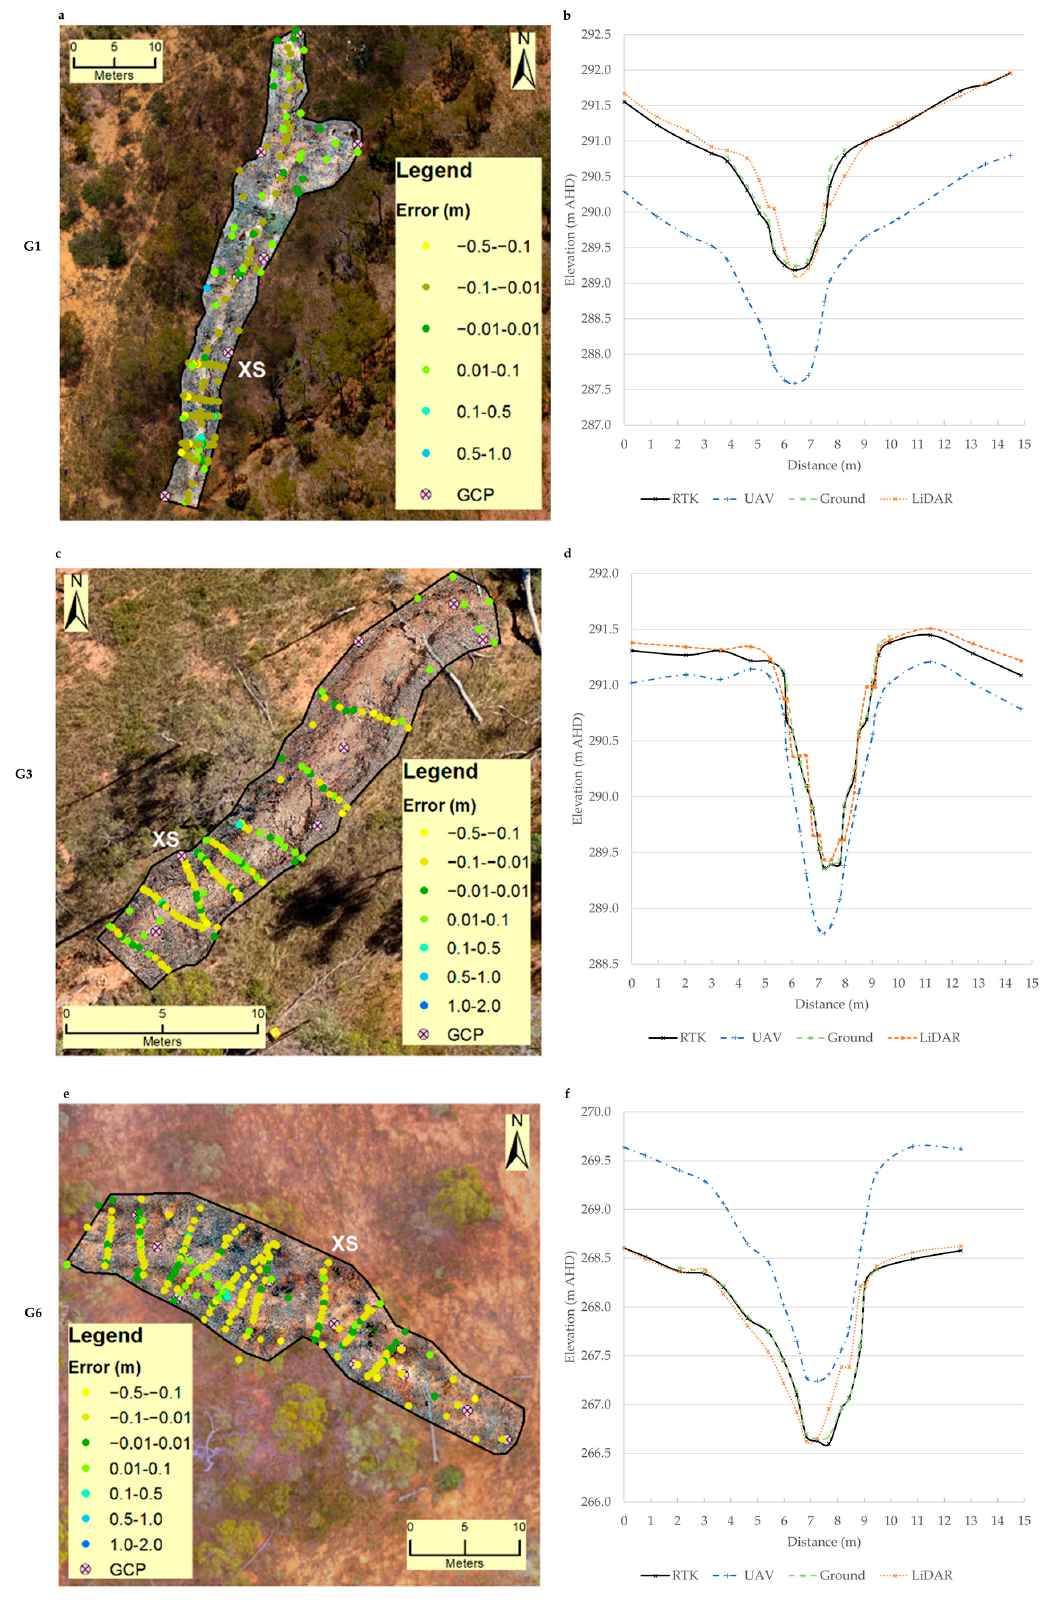
Figure 7. ( a , c , e ) Map showing the difference in elevation between RTK validation points and the ground DSM; and ( b , d , f ) comparison of cross-sectional profile between different survey platforms, for gully G1, G3, G6. Cross section locations shown on map.